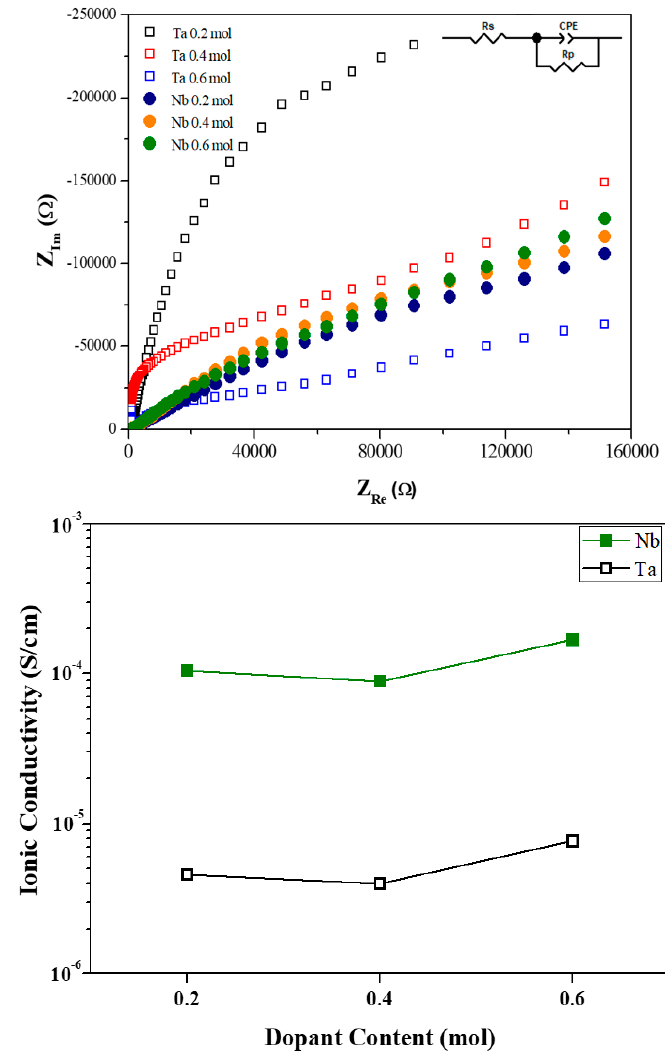
Figure 3. Electrochemical impedance spectroscopy (EIS) results of M-doped LLZO ceramics (mono-doping of the Zr 4+ site with 0.2–0.6 mol Nb or Ta): ( a ) Nyquist plots ( Z Re and Z Im : real and imaginary part of impedance, respectively; inset: equivalent circuit, where R s is electrolyte resistance; R p is resistance due to charge accumulation at the interface; and CPE is constant phase element); ( b ) Li-ion conductivity according to dopant concentration.